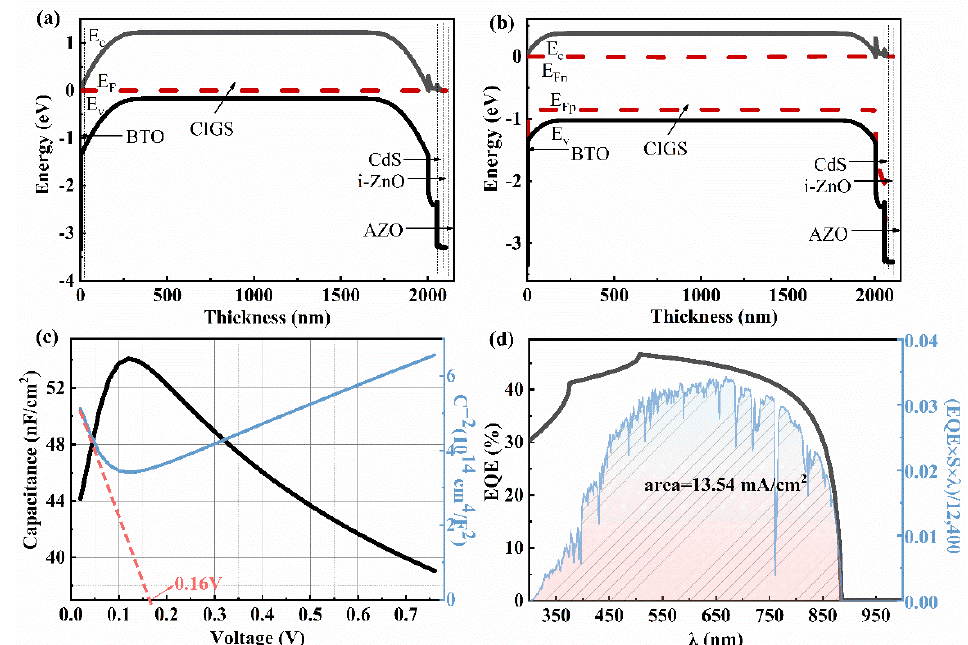
Figure 6. The energy band diagram, C - V , and EQE curves of the solar cell with a device structure of Mo/BTO/CIGS/CdS/i-ZnO/AZO and a CIGS bandgap of 1.40 eV: ( a ) under non-light conditions, ( b ) under the AM1.5 G, 1SUN, 1000 W/m 2 condition, ( c ) C - V curve and C −2 - V curve, ( d ) EQE curve and the J sc value from the integral curve based on the expression EQE × S × λ . 12,400